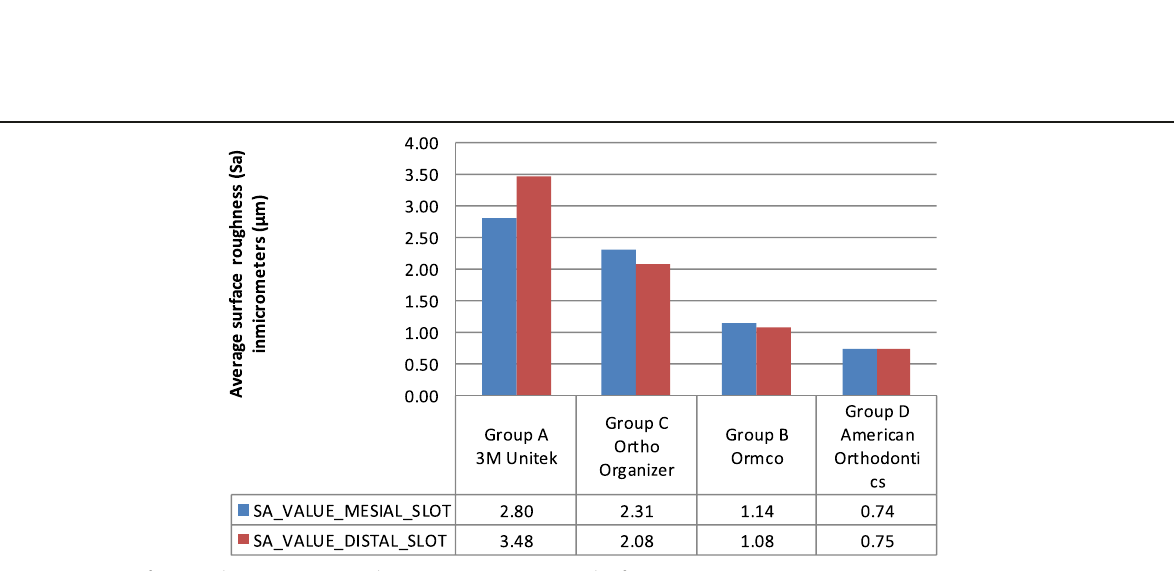
Fig. 8 Average surface roughness (Sa) mean values in micrometre across the four groups